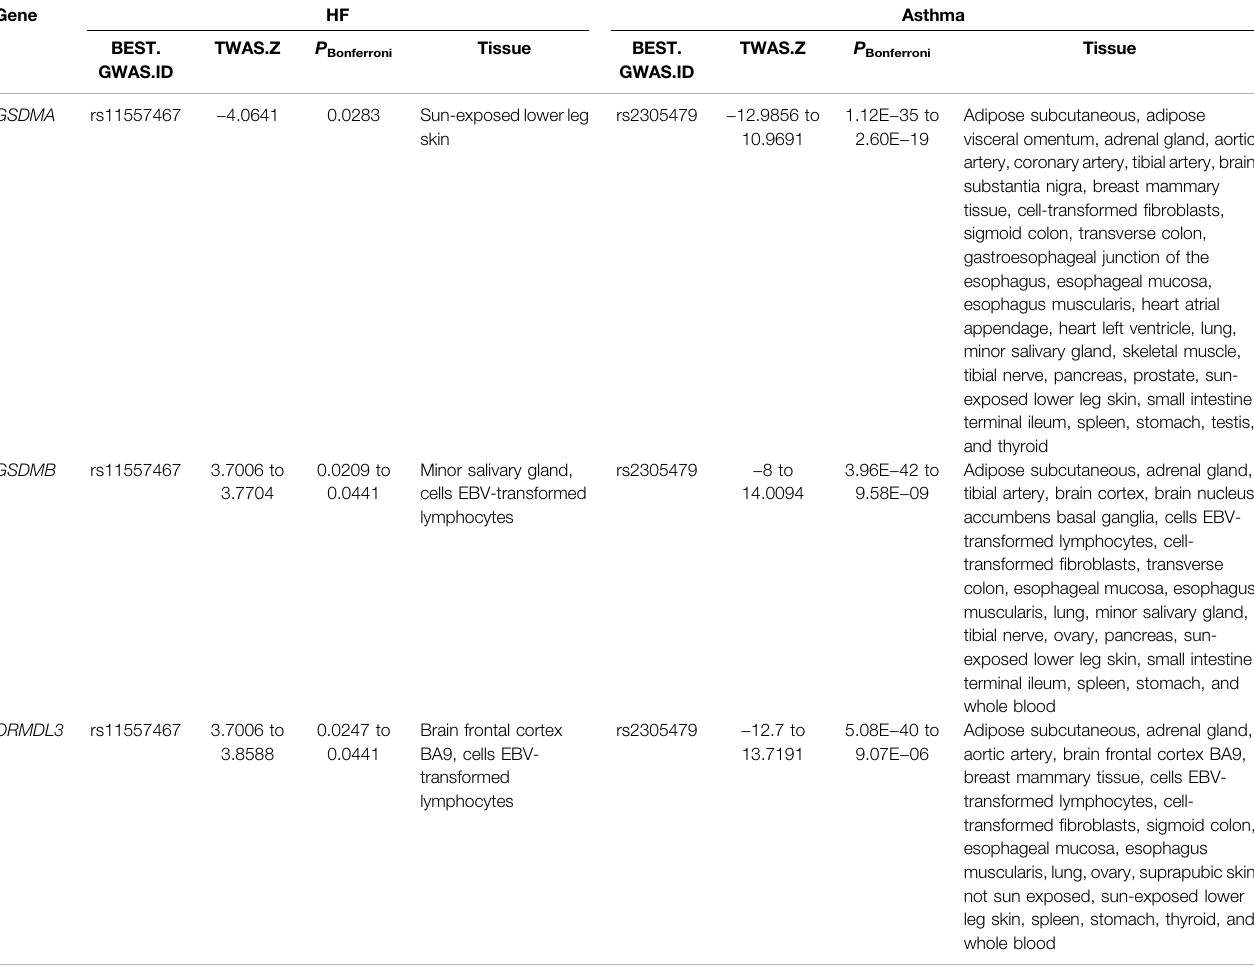
TABLE 3 | TWAS signi fi cant genes shared between asthma and HF. Gene HF BEST.